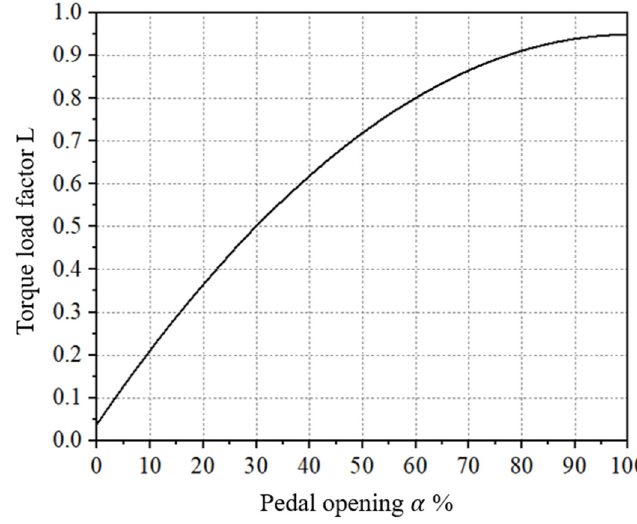
Figure 11. Pedal opening vs. torque load factor curve.